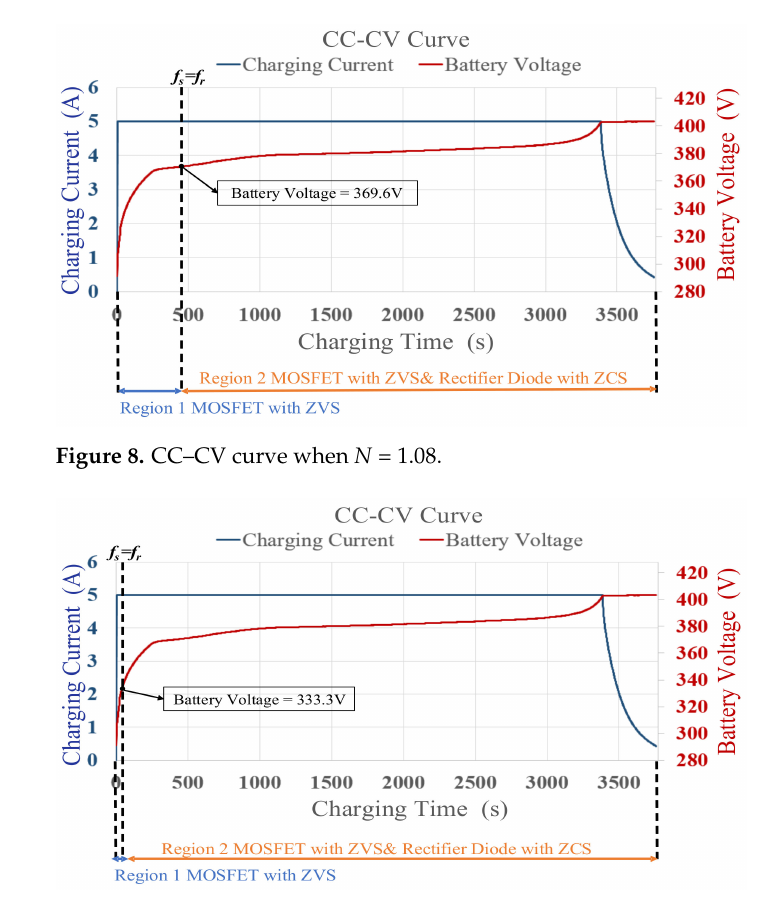
Figure 9. CC–CV curve when N =